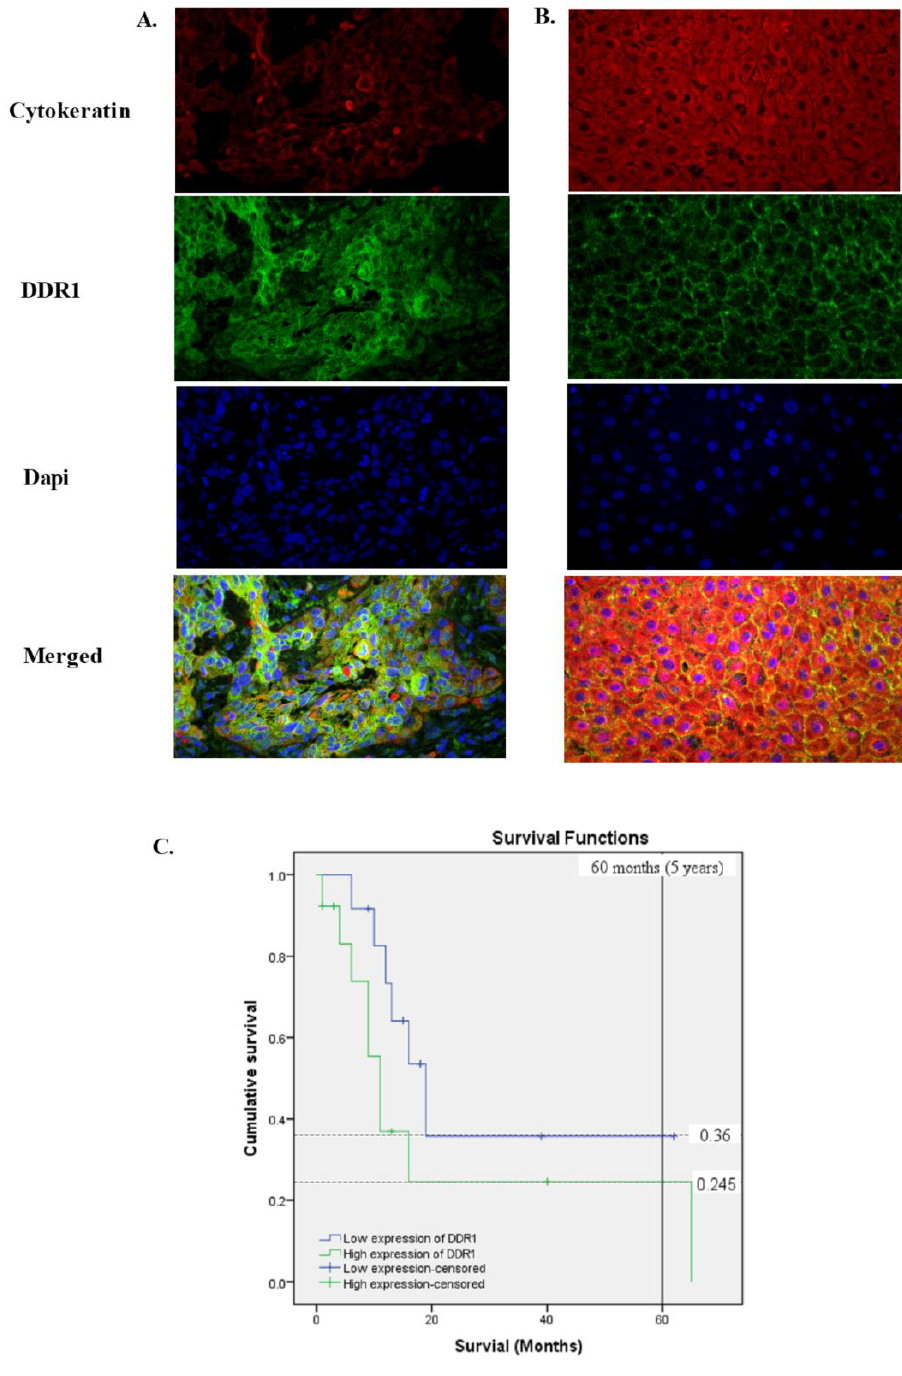
Figure 4. Expression of discoidin domain receptor 1 (DDR1) in oropharyngeal squamous cell carcinoma (OPSCC). Tissues were multiplex-stained with pan-cytokeratin cocktail AE1 / AE3 (Cy3, red) and DDR1 (fluorescein, green) antibodies, plus 4 (cid:48) ,6-diamidino-2-phenylindole (DAPI) (blue) nuclear counterstain. DDR1 expression in OPSCCs was ( A ) cytoplasmic and membraneous or ( B ) membraneous. Representative images are shown and were captured using Metamorph Pathology Imaging System (Nikon, Tokyo, Japan; magnification × 60). Examples of DDR1 expression in oral squamous cell carcinoma tissues are shown in Supplementary Figure S5. ( C ) High DDR1 expression in OPSCC patients was correlated with worse survival. Patients with high DDR1 expression have a lower 5-year survival rate (33%) than that of patients with low DDR1 expression (78%), log-rank (Mantel–Cox) ( p =